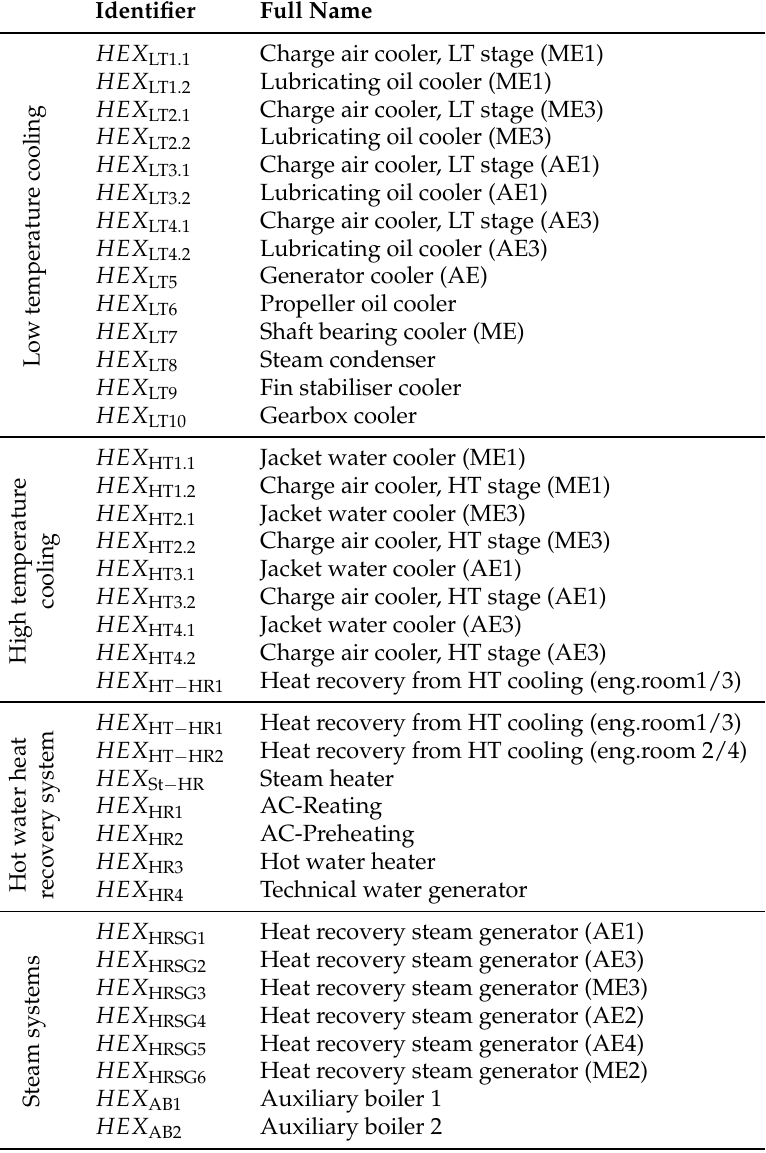
Table A7. Full list of exchangers in the ship’s heat exchanger